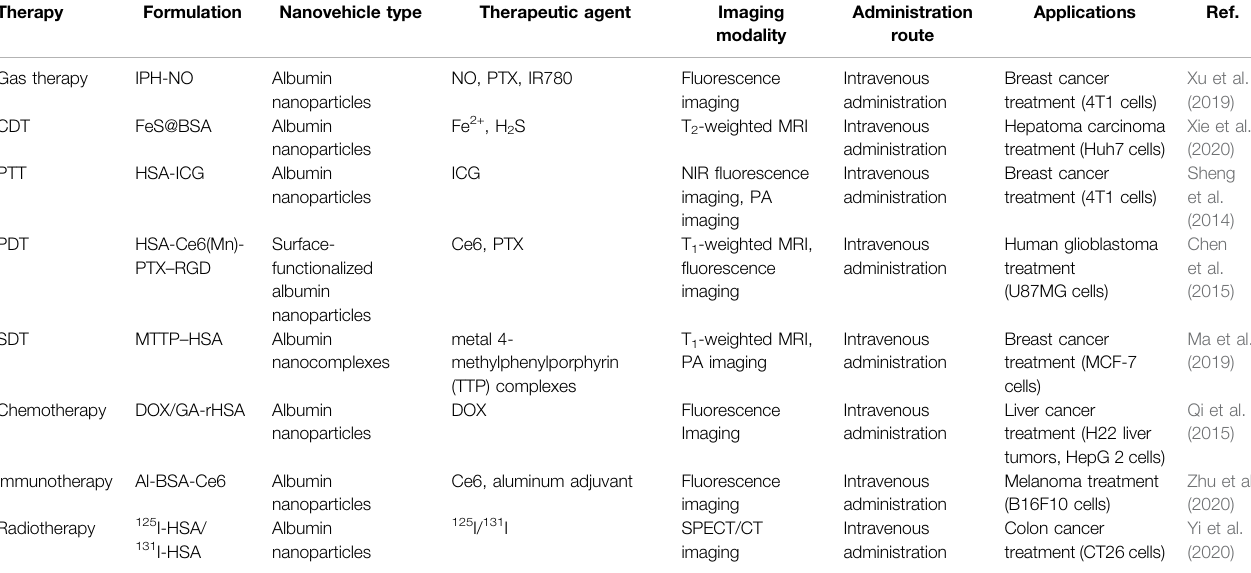
TABLE 1 | Summary of representative applications of serum albumin-based nanovehicles for cancer theranostics.